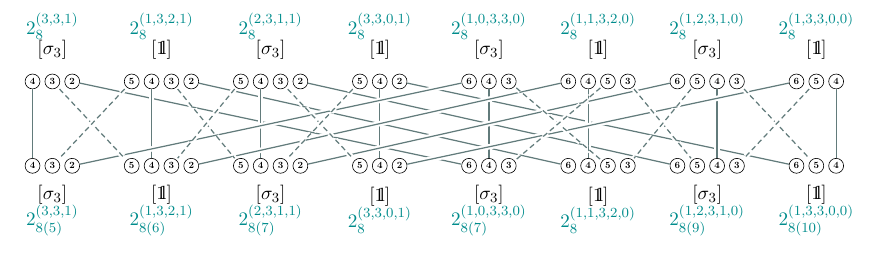
Figure 16 . T -duality chain of the E (8;0) -branes.